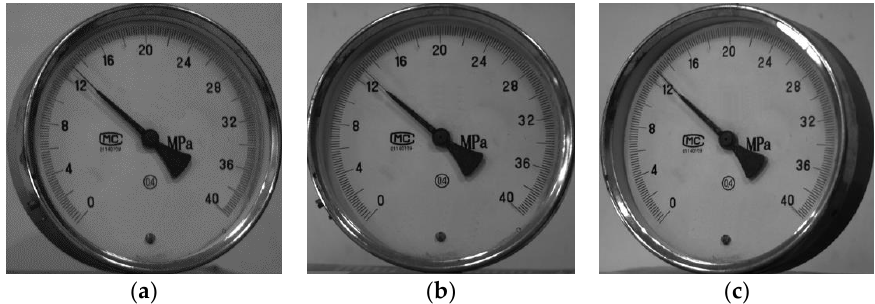
Figure A4. The meter image taken by camera from three angles when the reading of the pointer meter is 12.9; ( a ) the camera at position 1; ( b ) the camera at position 2; ( c ) the camera at position 3.